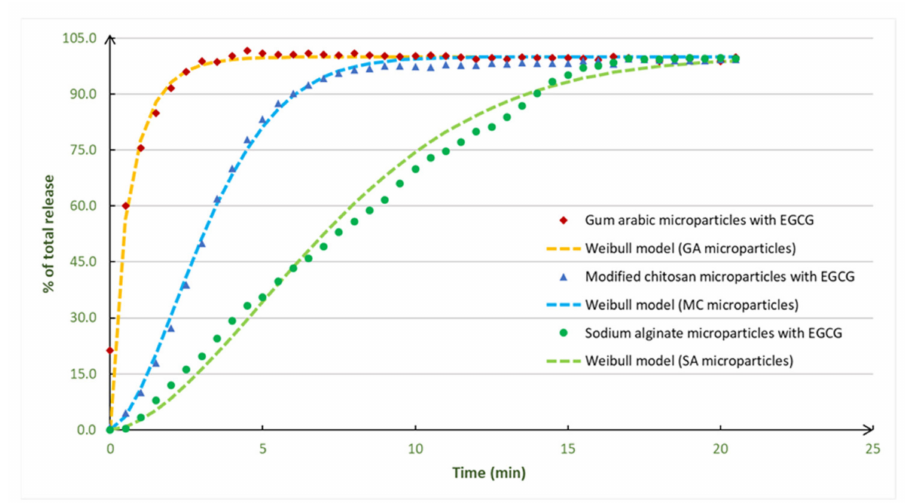
Figure 4. Experimental data and Weibull model adjustments for the EGCG release profiles obtained with microparticles prepared with different encapsulating agents. The experimental release profiles were obtained, in triplicate, and the variation coefficients were determined for each release time and were less than 10% for the all the release times.